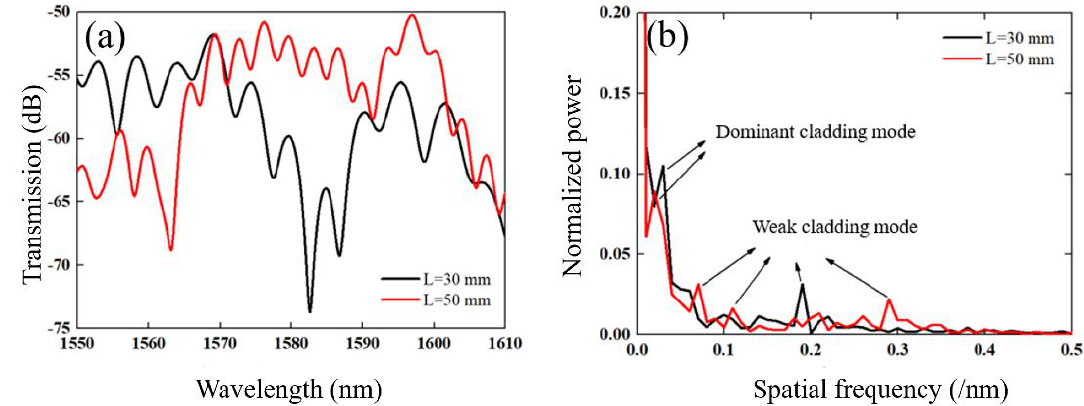
Figure 2. ( a ) Transmission spectrum of the sensor with different TCF lengths ( L = 30 mm, L = 50 mm). ( b ) Spatial frequency of fiber fusion based MZI sensor with different lengths.